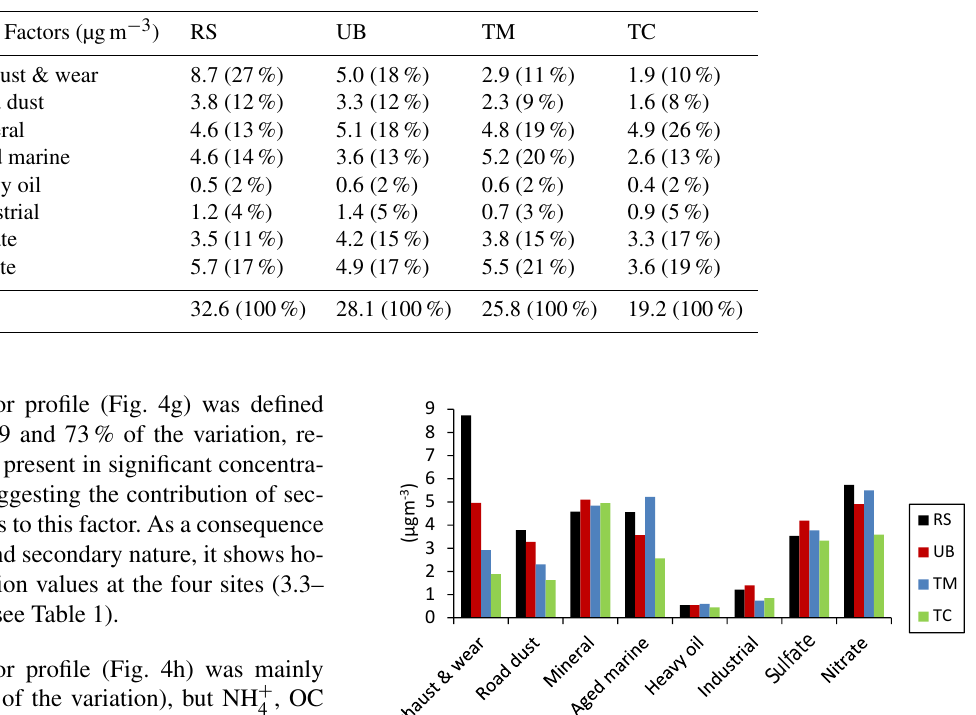
Table 1. Mean concentrations (µgm − 3 ) of PMF factors at the Road Site (RS), Urban Background (UB), Torre Mapfre (TM) and Torre Collserola (TC).